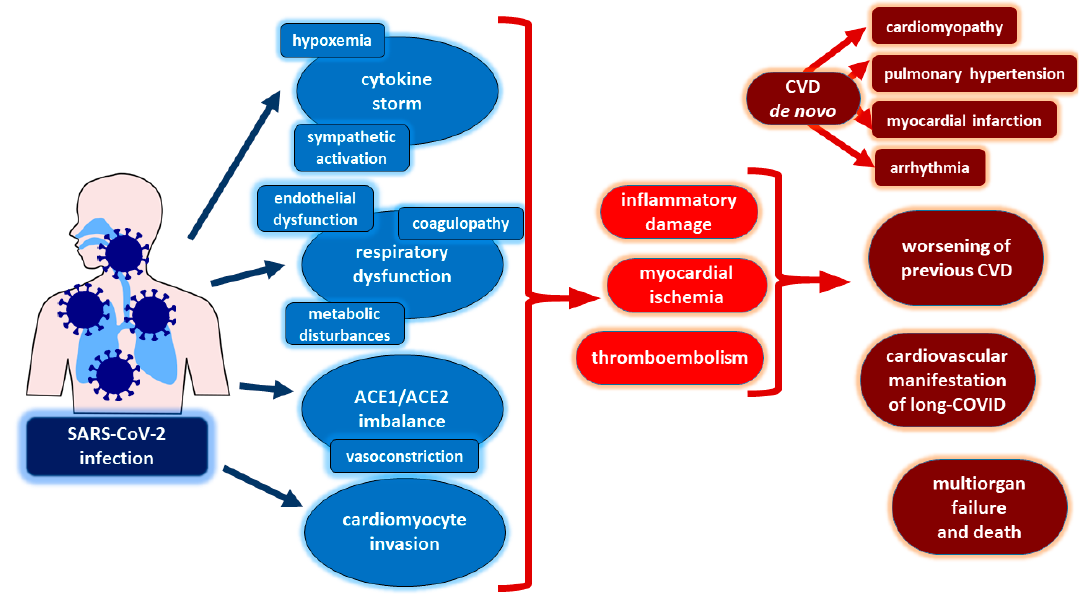
Figure 3. Cardiovascular complications of COVID-19 and diverse proven underlying pathomecha-